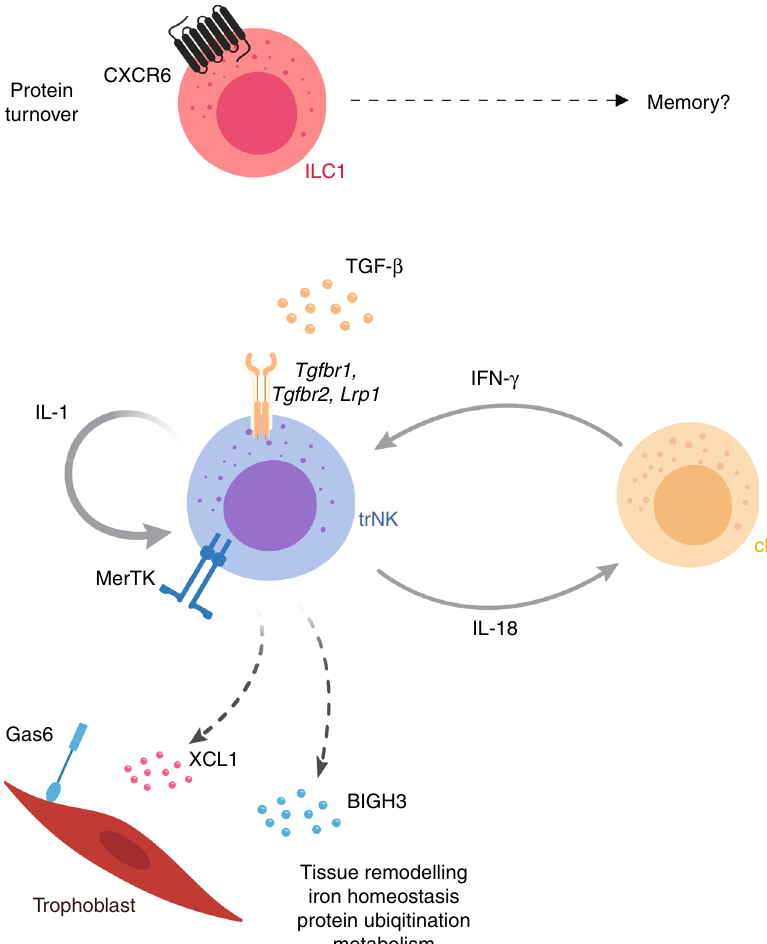
Fig. 6 Suggested g1 ILC functions in the pregnant mouse uterus. Eomes − CD49a + ILC1s are dominant before puberty and speci fi cally expand in second pregnancies, when the expression of CXCR6 is upregulated, marking them as potential memory cells. Eomes + CD49a + NK cells (trNK) are most abundant during early pregnancy and may well be the cellular hub of uterine g1 at mid-gestation. They indeed showcase gene signatures of responsiveness to TGF- β , connections with trophoblast, epithelial, endothelial and smooth muscle cells, leucocytes, as well as extracellular matrix. They also express genes involved in anaerobic glycolysis, lipid metabolism, iron transport and protein ubiquitination. Conventional NK cells expand late in gestation and may engage in crosstalk with trNK cells involving IL-18 and IFN-